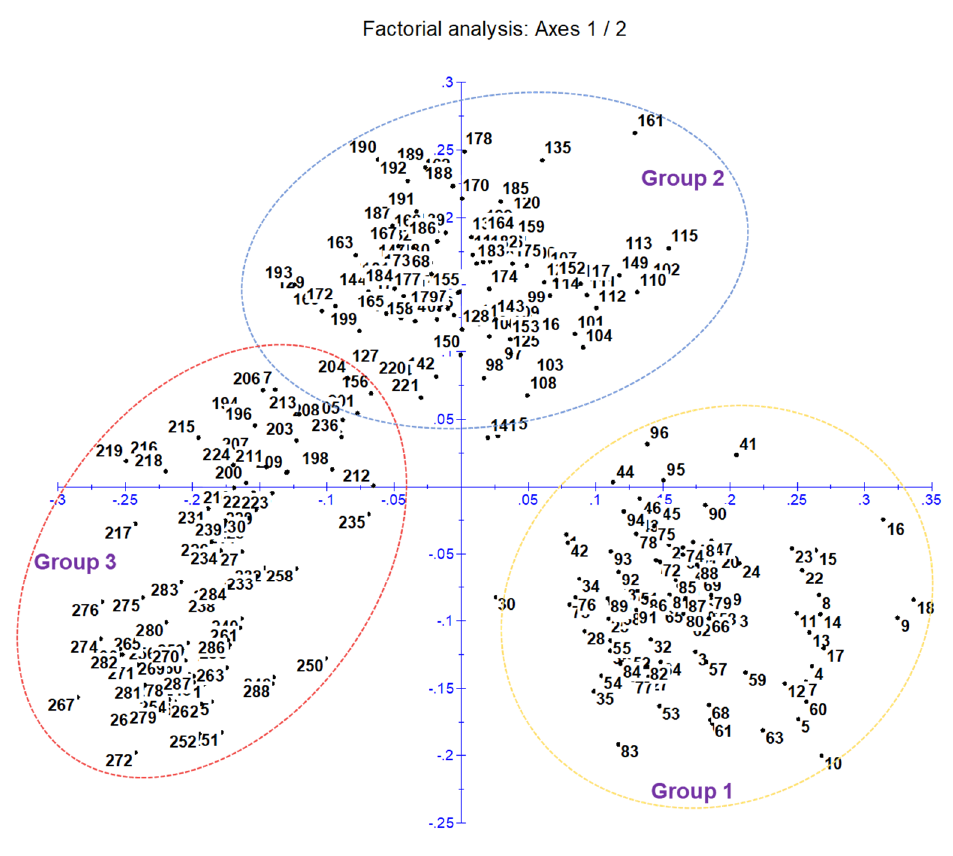
Figure 2. Principal coordinate analysis (factorial analysis) classifies 288 genotypes into three main clusters and agrees with neighbor-joining clustering.